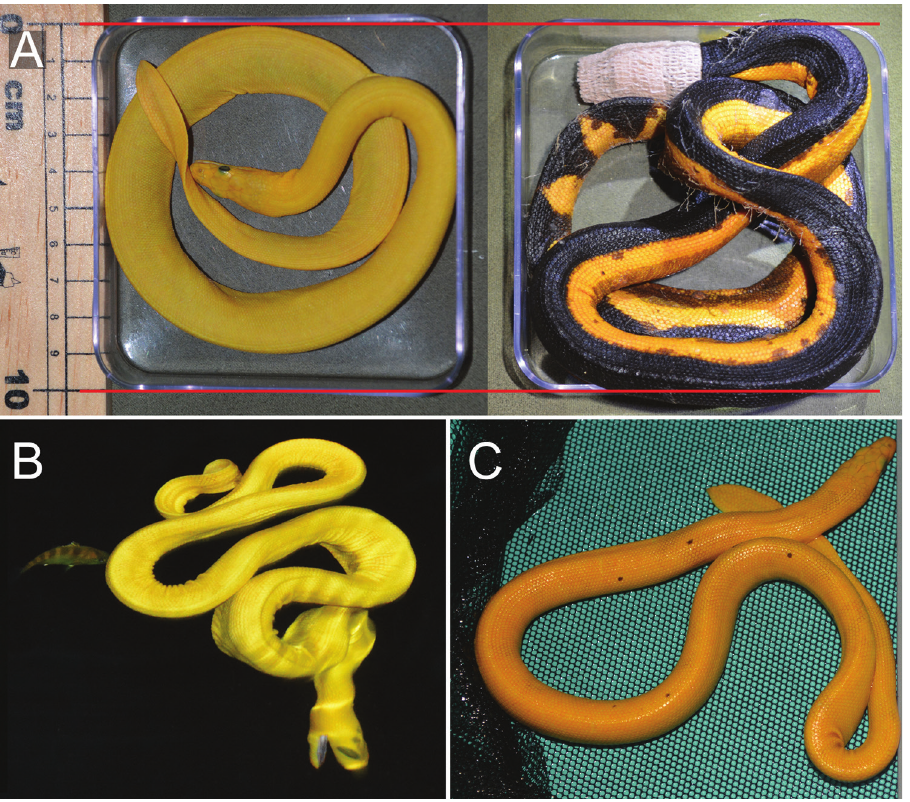
Figure 2. Hydrophis platurus xanthos sharply contrasts typical H. platurus in color, body size and behavior. A Scaled size comparison of yellow sea snake, TL 43 cm (left), and yellow-bellied sea snake, TL 69 cm (right; note the use of Vetrap as a calming mask and sickly condition of the specimen) B ambush posture of H. p. xanthos ; floating at the sea surface at night in a sinusoidal shape, head below, mouth agape C although predominantly yellow, xanthic individuals often possess black spots along the